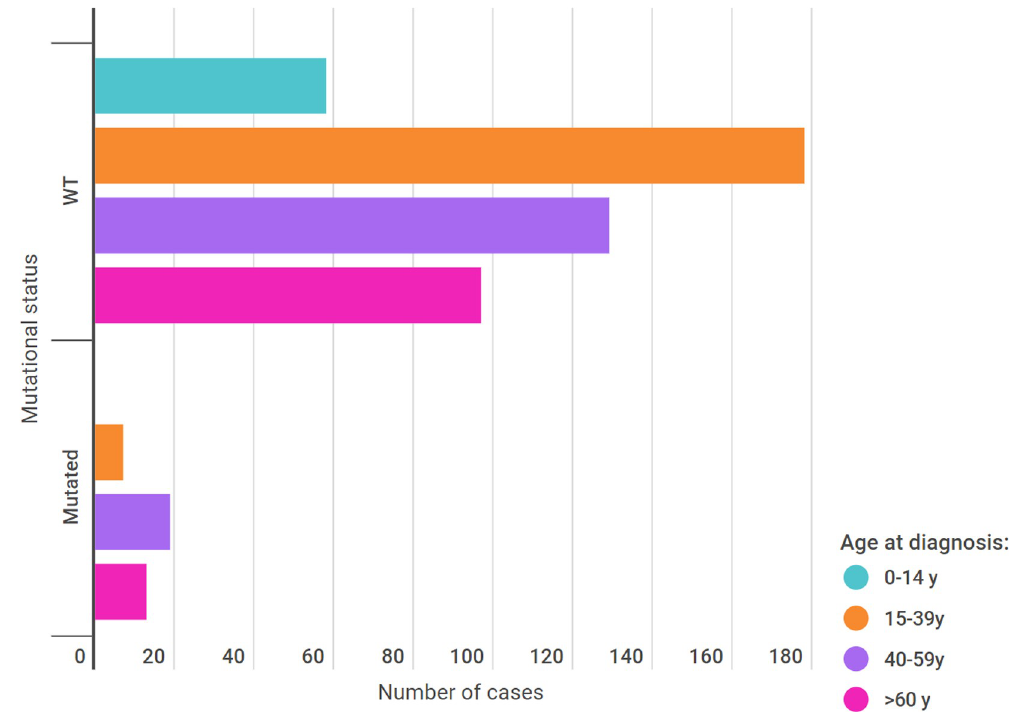
Fig 1. Age distribution according to mutational